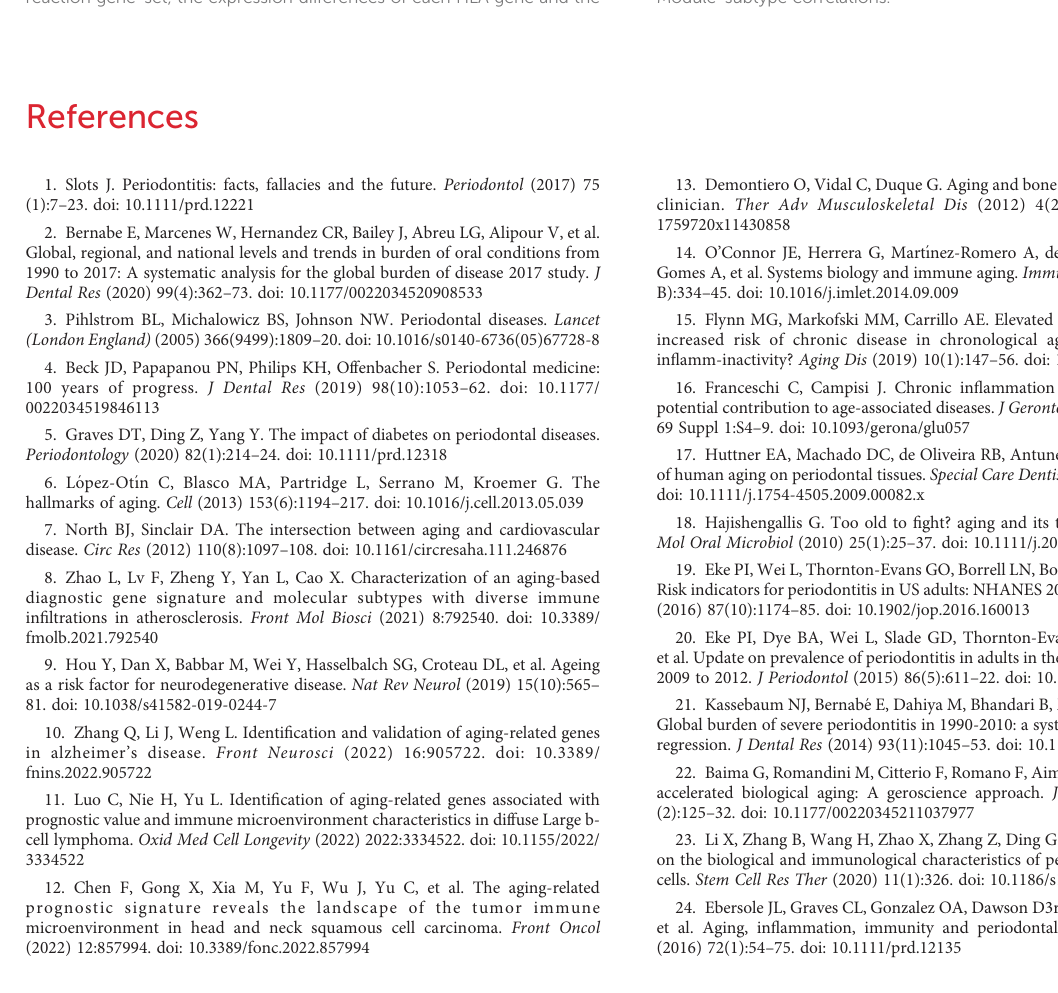
SUPPLEMENTARY TABLE 1 Characteristics of selected GEO datasets. SUPPLEMENTARY TABLE 2 Three hundred seven genes related to aging. SUPPLEMENTARY TABLE 3 The detail of clinical information on eight patients. SUPPLEMENTARY TABLE 4 The primer sequences for qRT-PCR. SUPPLEMENTARY TABLE 5 Differentially Expressed Aging Related Genes. SUPPLEMENTARY TABLE 6 The output results of the neural network model. SUPPLEMENTARY TABLE 7 Aging modi fi cation patterns. SUPPLEMENTARY TABLE 8 Aging related genes in periodontitis. SUPPLEMENTARY TABLE 9 Module-subtype